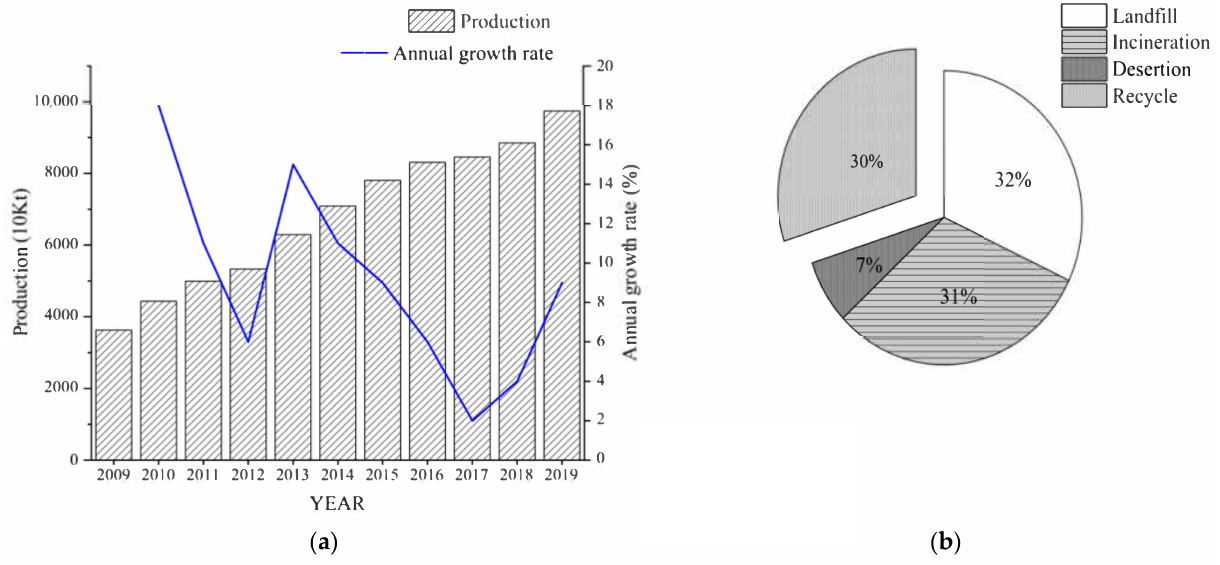
Figure 1. The production and disposal of plastics in China: ( a ) primary plastics production (2009–2019); ( b ) disposal of plastic waste in